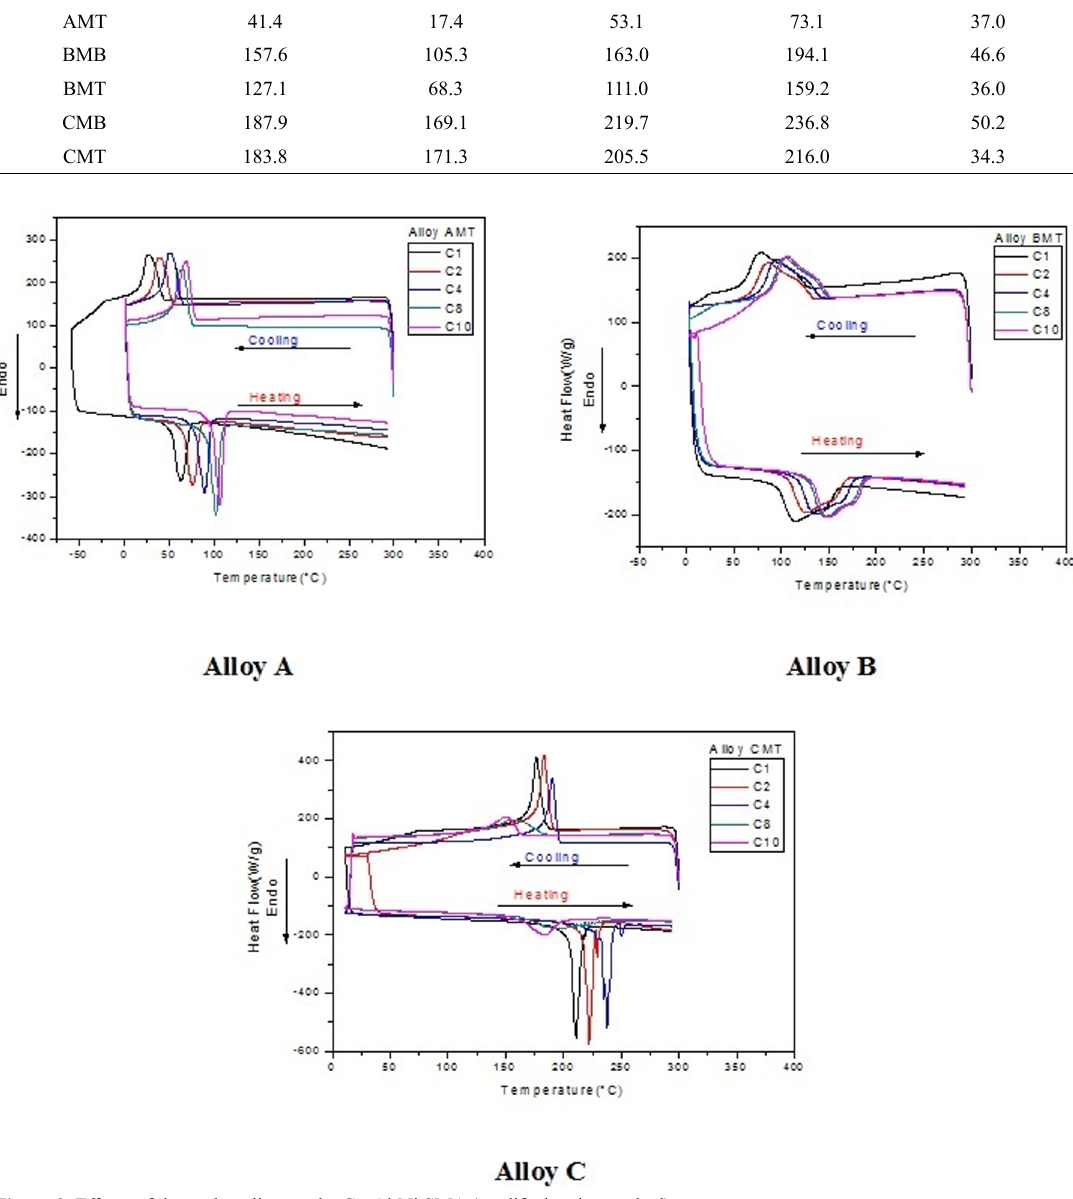
Figure 2. Effects of thermal cycling on the Cu-Al-Ni SMA (modified and quenched). at relatively high temperatures of cycled heating 9 . For all the modified alloys, it was found that these energies agree with the transformation enthalpies reported in the literature for Cu-Al-Ni SMA with 13.5 to 14.0 %wt. Al in the range of 5 to 10 J/g 1,5,6